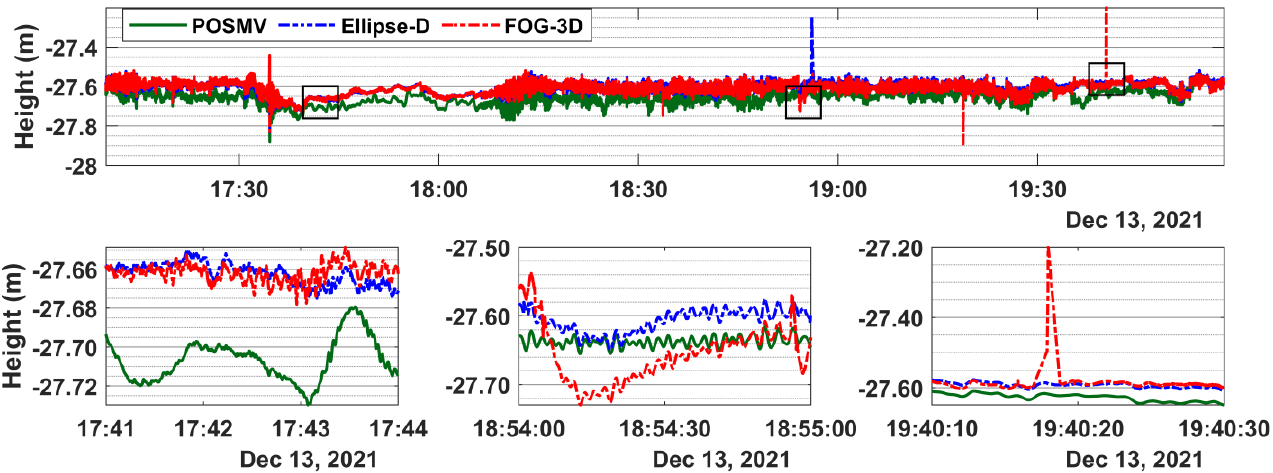
Figure 7. Top panel: ellipsoidal height time series for POSMV, Ellipse-D, and FOG-3D. Bottom panel: shows snippets at selected peaks. The mean offset between POSMV and the other systems is about 5 cm, and the 95% ordered statistics are about 8 cm.